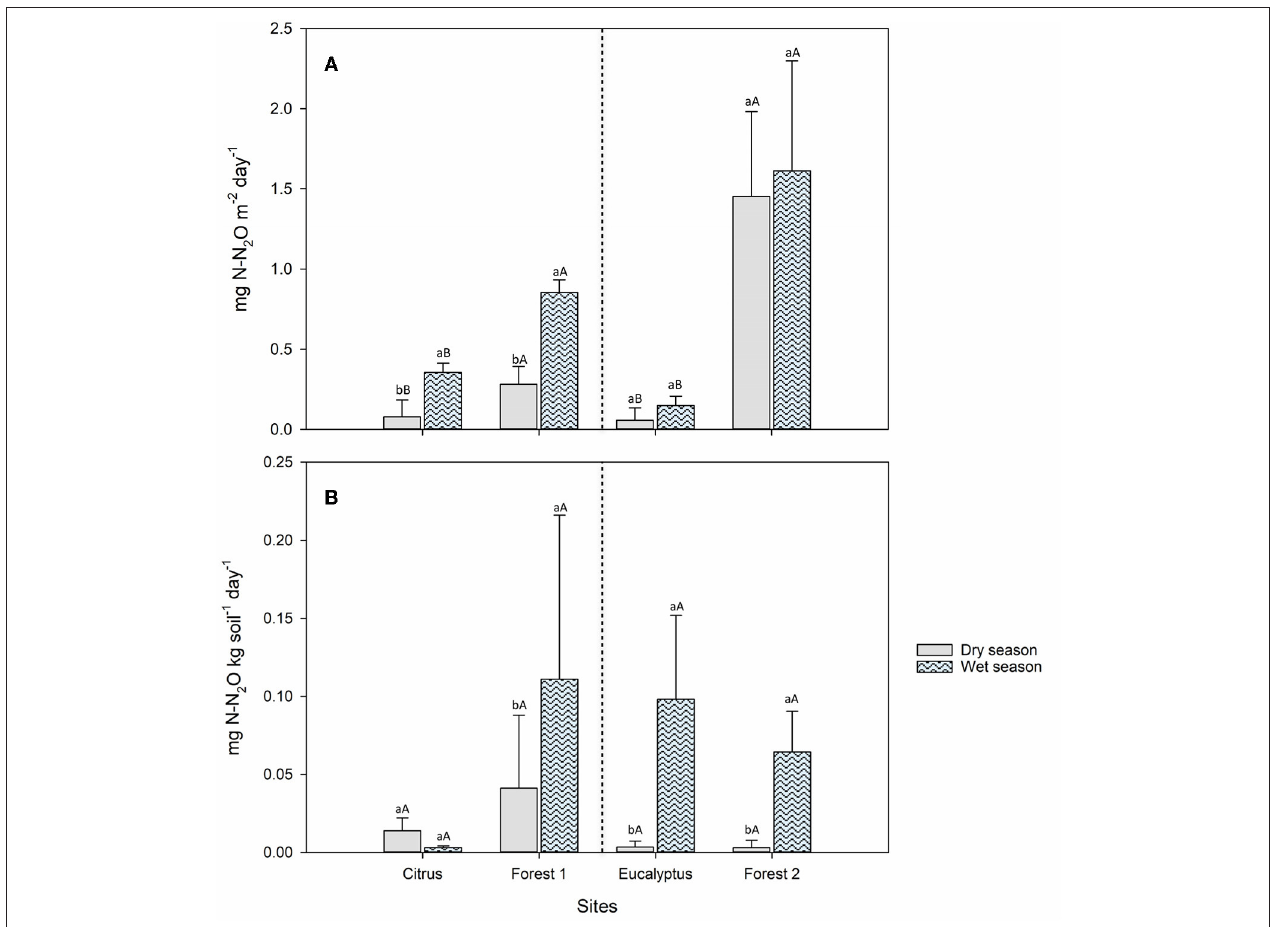
FIGURE 2 | Average N 2 O fluxes ( n = 5) from Citrus, Forest 1, Eucalyptus and Forest 2 sites for measurements made in the dry (solid) and wet (pattern) seasons. (A) Field measurements (B) Soil incubation measurements, moisture at 70% of water holding capacity. Tukey’s HSD test ( P < 0.05) was performed to compare the dry and wet seasons within the same sampling site (lower-case letters) and the agricultural vs. adjacent forest site (Citrus vs. Forest 1 and Eucalyptus vs. Forest 2) in the same season (upper-case letters).